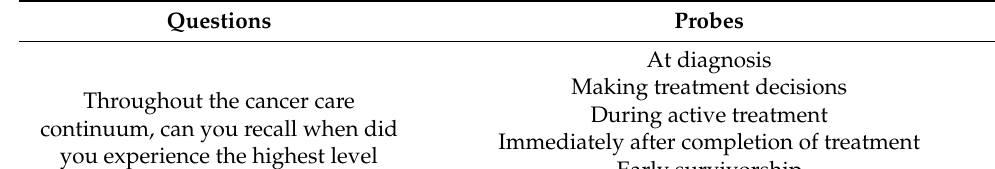
Table 2. Samples of interview